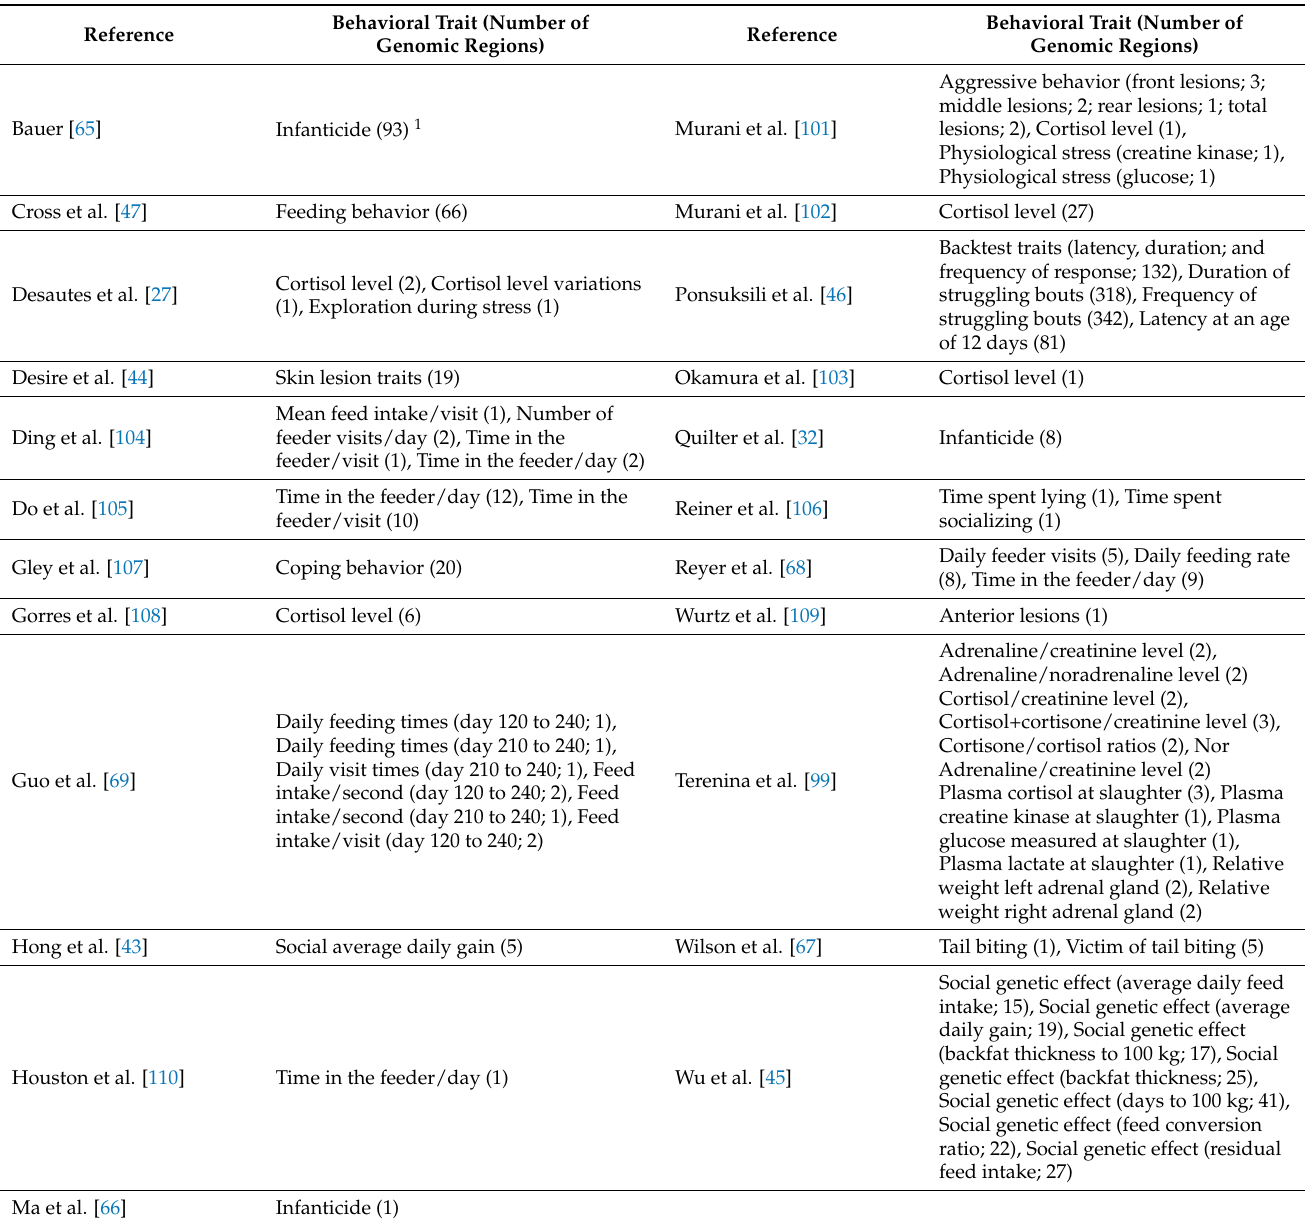
Table 3. References, behavior-related trait, and number of genomic regions identified for